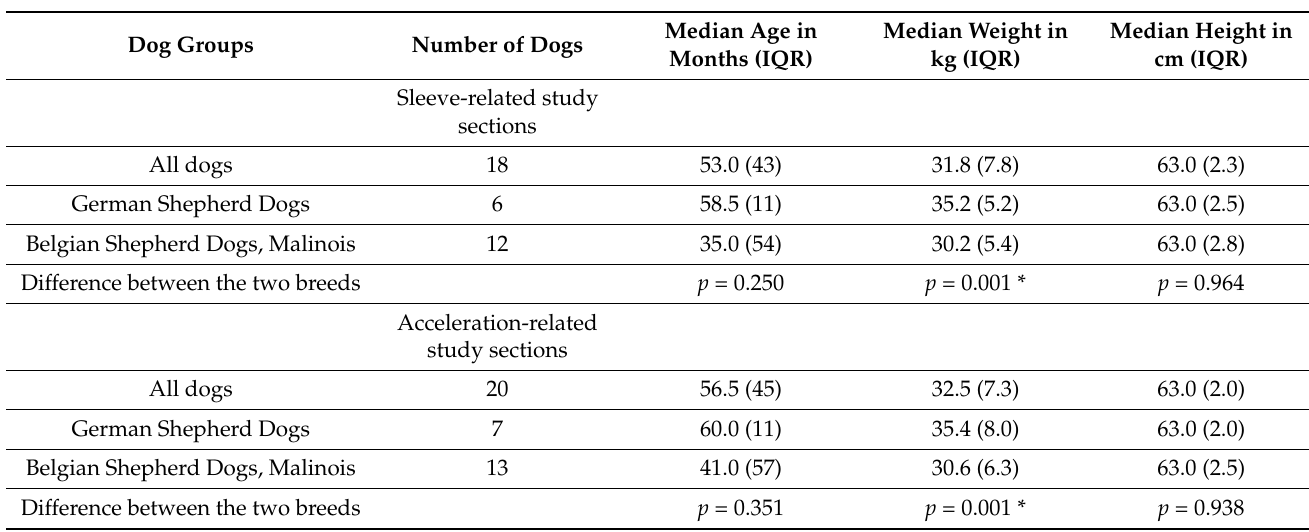
Table 1. Descriptive information on the dogs included in all study sections.